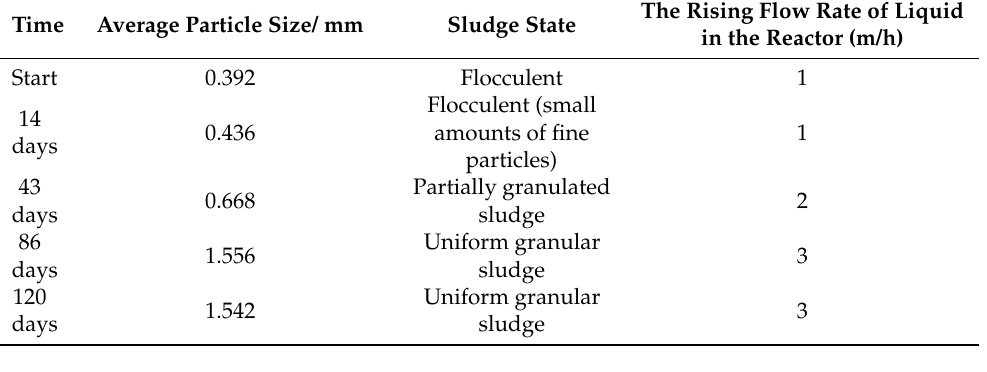
Table 2. Sludge properties and liquid upward flow rate at each stage in the reactor.